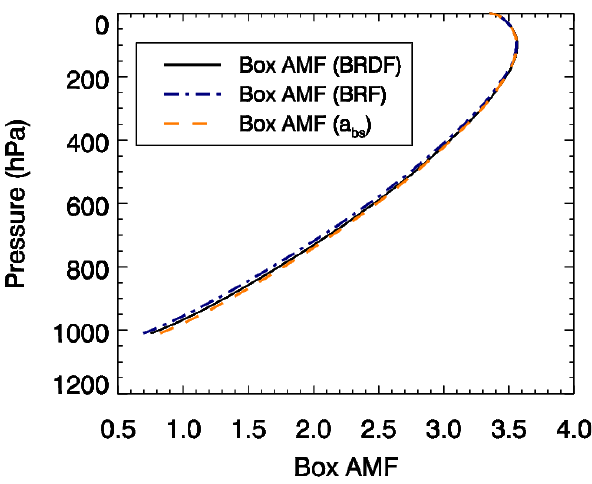
Fig. 3: Profiles of box air mass factors for a clear-sky pixel ( θ = 60°, υ = 45°, φ = 120°) Fig. 3. Profiles of box air mass factors for a clear-sky pixel ( θ =60 ◦ , computed with (a) full BRDF surface treatment ( f iso =0.06, f vol =0.02, f geo =0.01), (b) Lambertian υ =45 ◦ , φ =120 ◦ ) computed with (a) full BRDF surface treatment albedo with a value of 0.04 equal to the BRF for the given viewing geometry, and (c) ( f iso =0.06, f vol =0.02, f geo =0.01), (b) Lambertian albedo with a for the given SZA. Lambertian albedo of 0.05 equal to the black-sky bs a value of 0.04 equal to the BRF for the given viewing geometry, and (c) Lambertian albedo of 0.05 equal to the black-sky a bs for the given